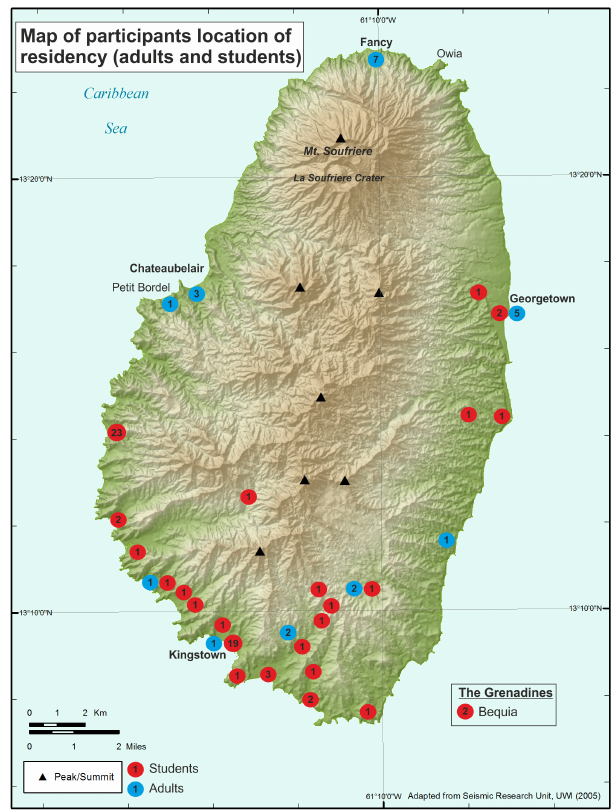
Figure 2. Map showing the location of residency for most partic- ipants used in this study. The number of participants stated is the number of completed and usable data sets of which provided loca- tion of residency information (students, who participated in all types of sessions, N = 68 and adults N =